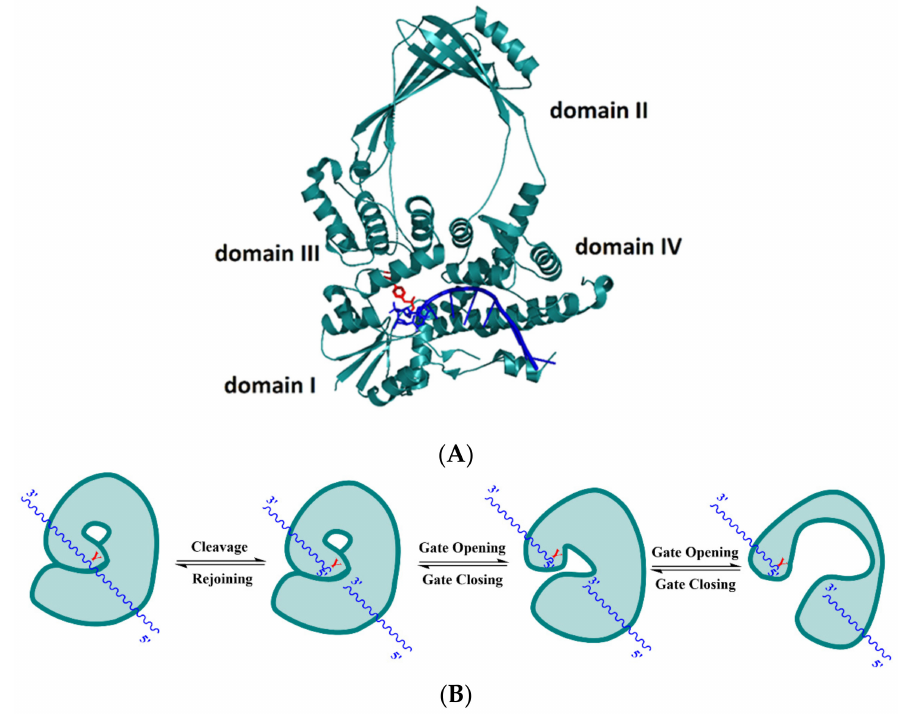
Figure 1. DNA-gate formed by cleavage of G-strand DNA by type IA topoisomerase ( A ) Crystal structure of covalent complex between single-stranded DNA (ssDNA) and E. coli topoisomerase I N -terminal domains I to IV (Protein Data Bank (PDB) 3PX7). The active tyrosine residue Y319 is illustrated with the red color, and ssDNA is represented by the blue color. ( B ) Gate opening and closing dynamics of bacterial topoisomerase IA. The enzyme is represented by the green shape and the ssDNA is represented by the blue wavy line. The letter Y stands for the active site tyrosine residue